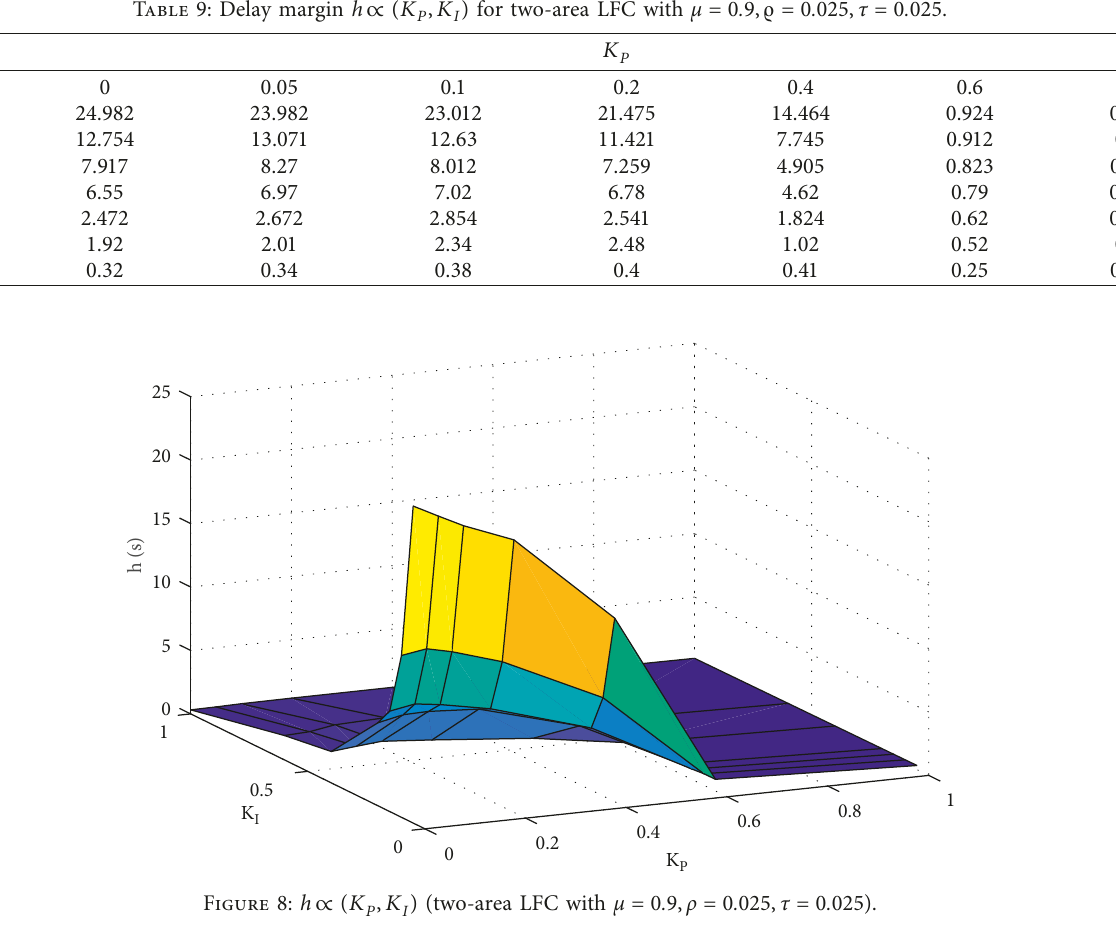
, K ) (two-area LFC with μ � 0 . 9 , ρ � 0 . 025 , τ � 0 . P I